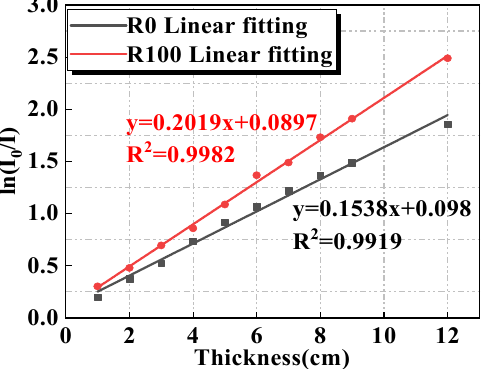
Figure 8. Typical results of ln( I 0 / I ) and thicknesses of tested specimens.